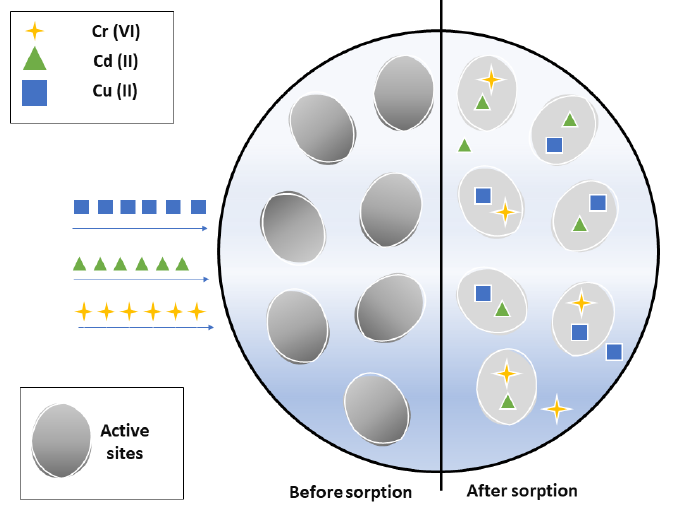
Figure 2. The figure aims to describe the mechanism of absorption of heavy